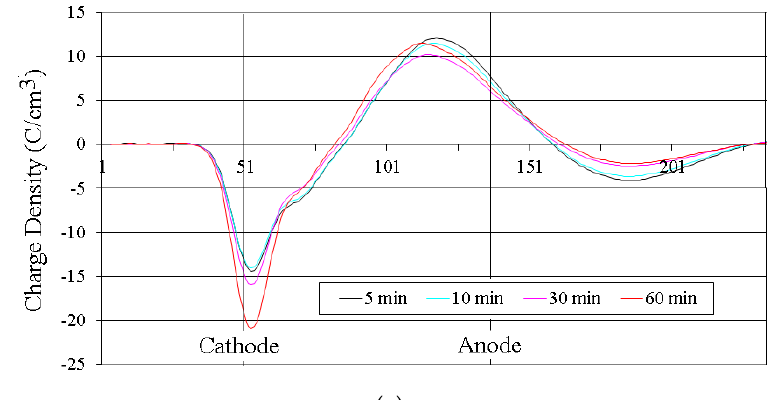
Figure 15. Cont. Figure 15. Cont.